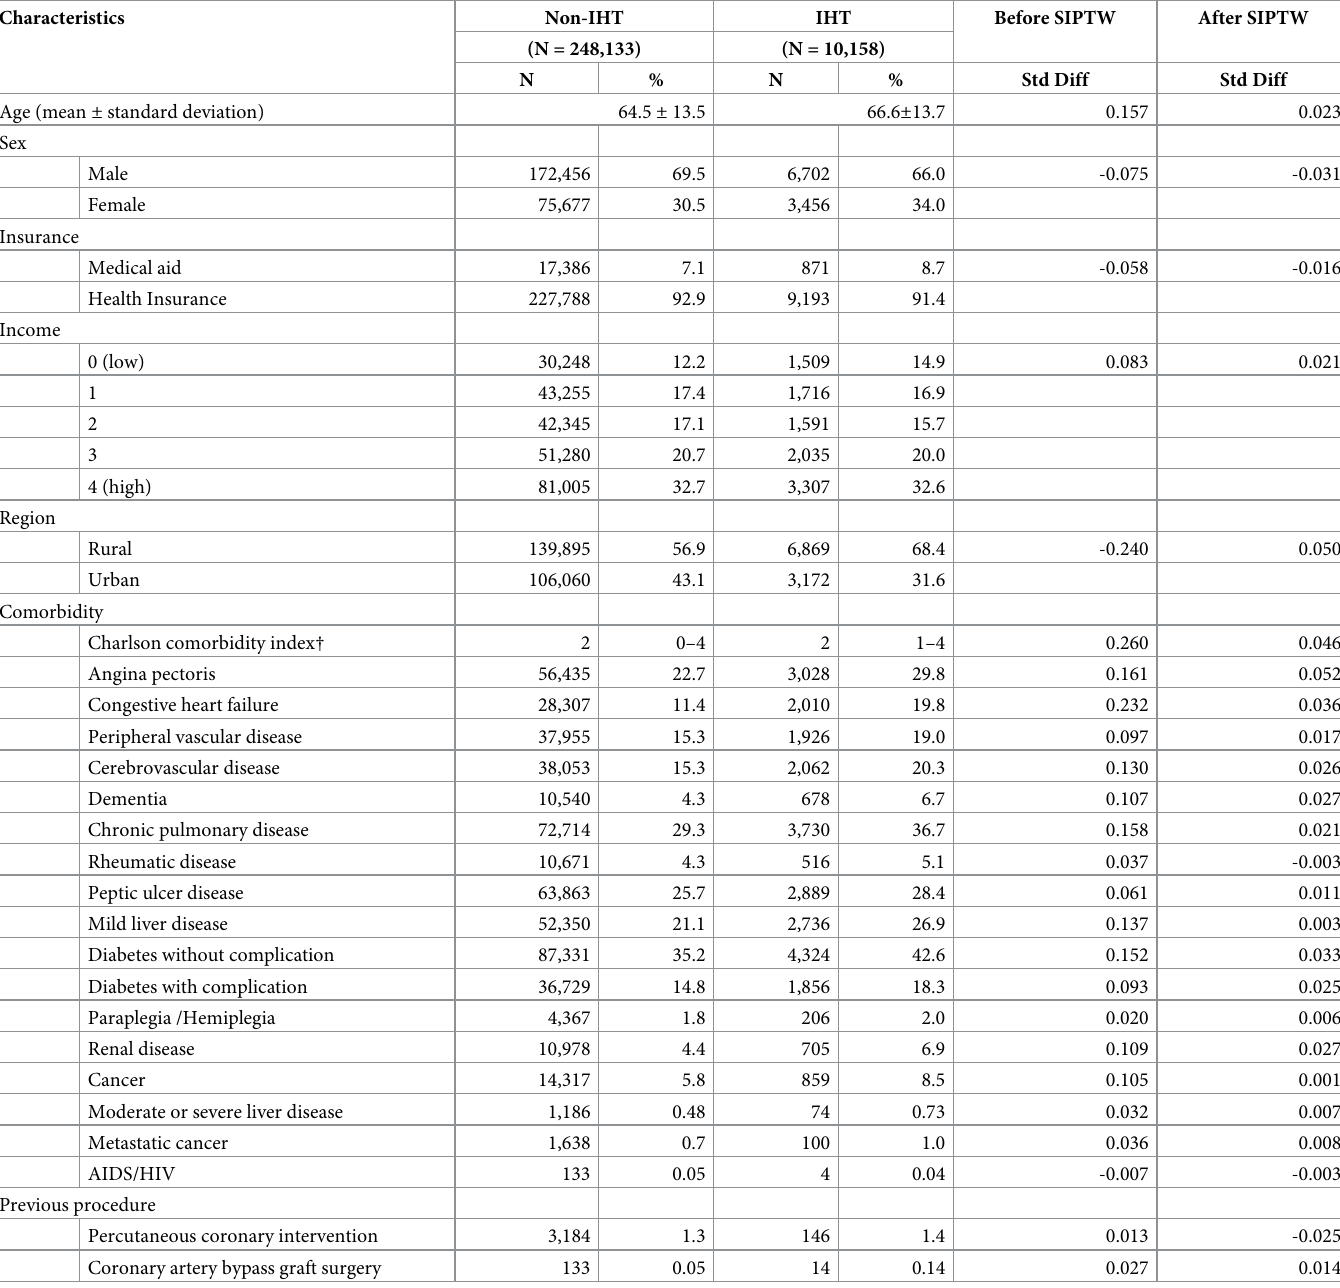
Table 1. Characteristics of the study